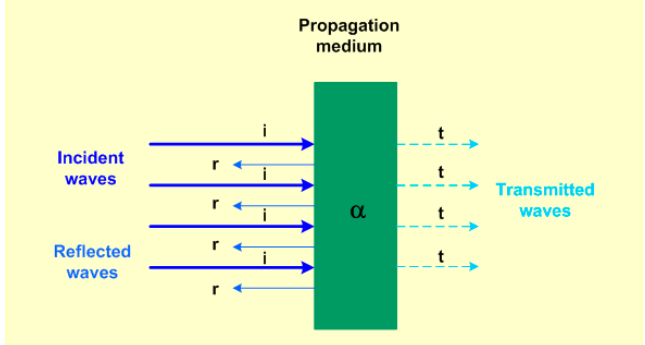
Figure 3. With normal incidences to the surface of the propagation medium, the acoustic waves are incident, reflected and transmitted. α is the attenuation that exists when the incident plane wave passes through a propagation medium.